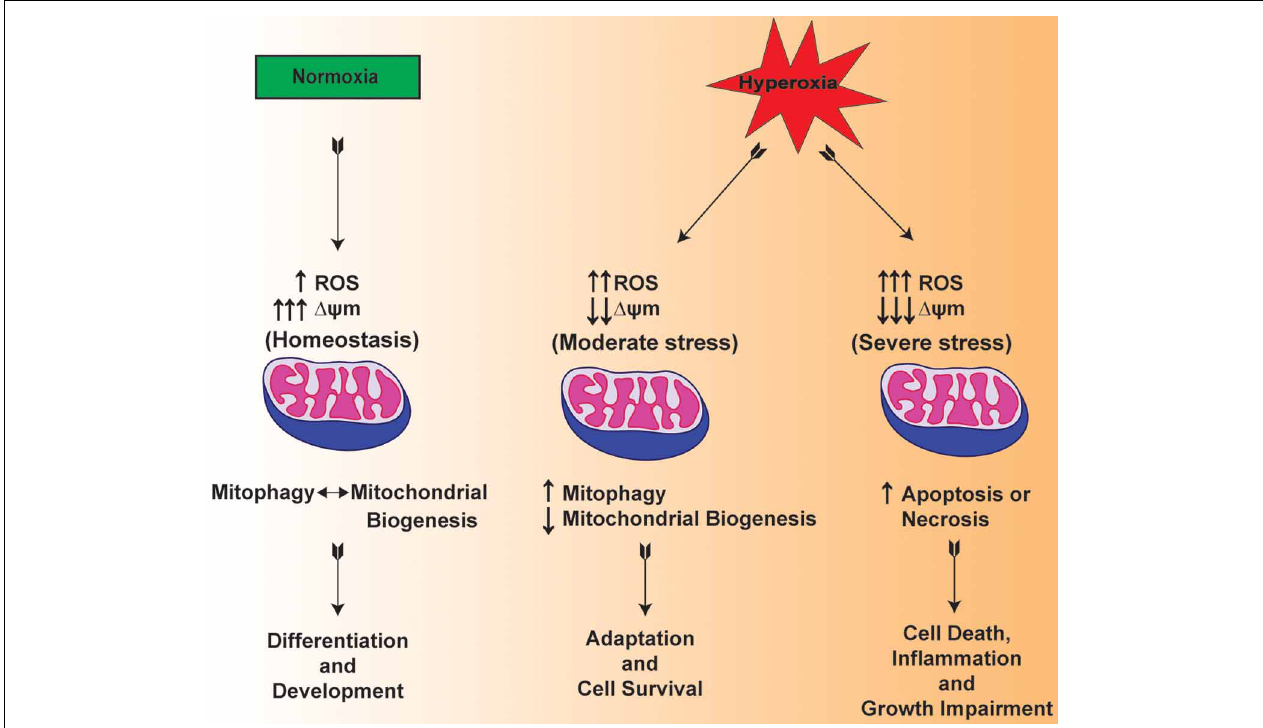
FIGURE 2 | Hypothetical mechanism illustrating the mitochondrial function in normoxia and mitochondrial dysfunction in hyperoxia exposed lungs of premature infants.